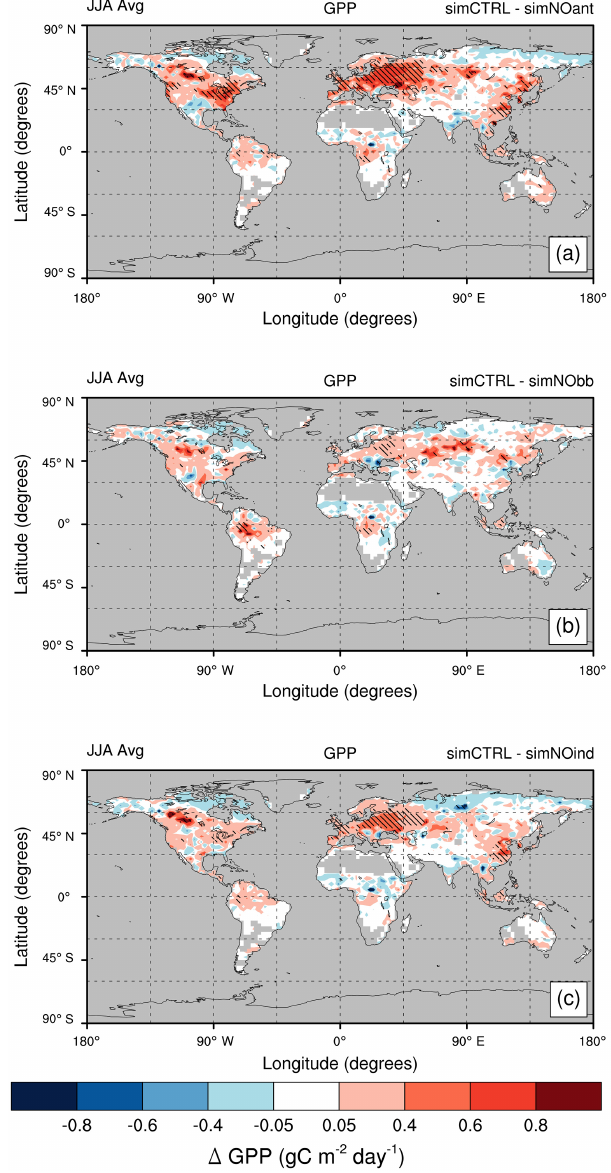
Figure 7. As Fig. 6 for seasonal (boreal summer, JJA) absolute change in gross primary productivity (GPP, in gCm − 2 day − 1 ) be- tween the control experiment (SimCTRL) and sensitivity experi- ments: (a) SimNOant, (b) SimNObb, and (c) SimNOind. real winter (Table S4). The area selected to represent central Africa mostly stretches toward south of the equator, where boreal winter corresponds to the growing season. The sea- sonal behavior of GPP in central Africa suggests that the bio- meteorological feedback to canopy temperature has a larger influence on plant productivity than reduction in direct radi-